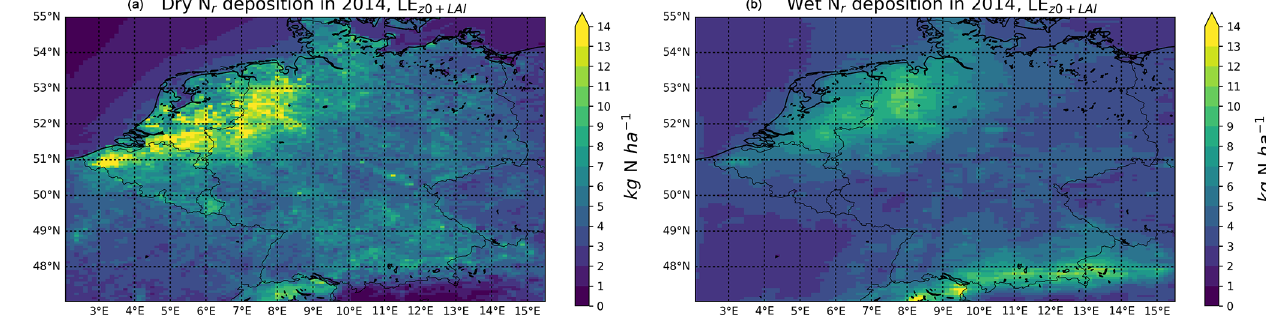
Figure 10. The modelled amount of dry (a) and wet (b) deposition in kgNha − 1 in 2014.